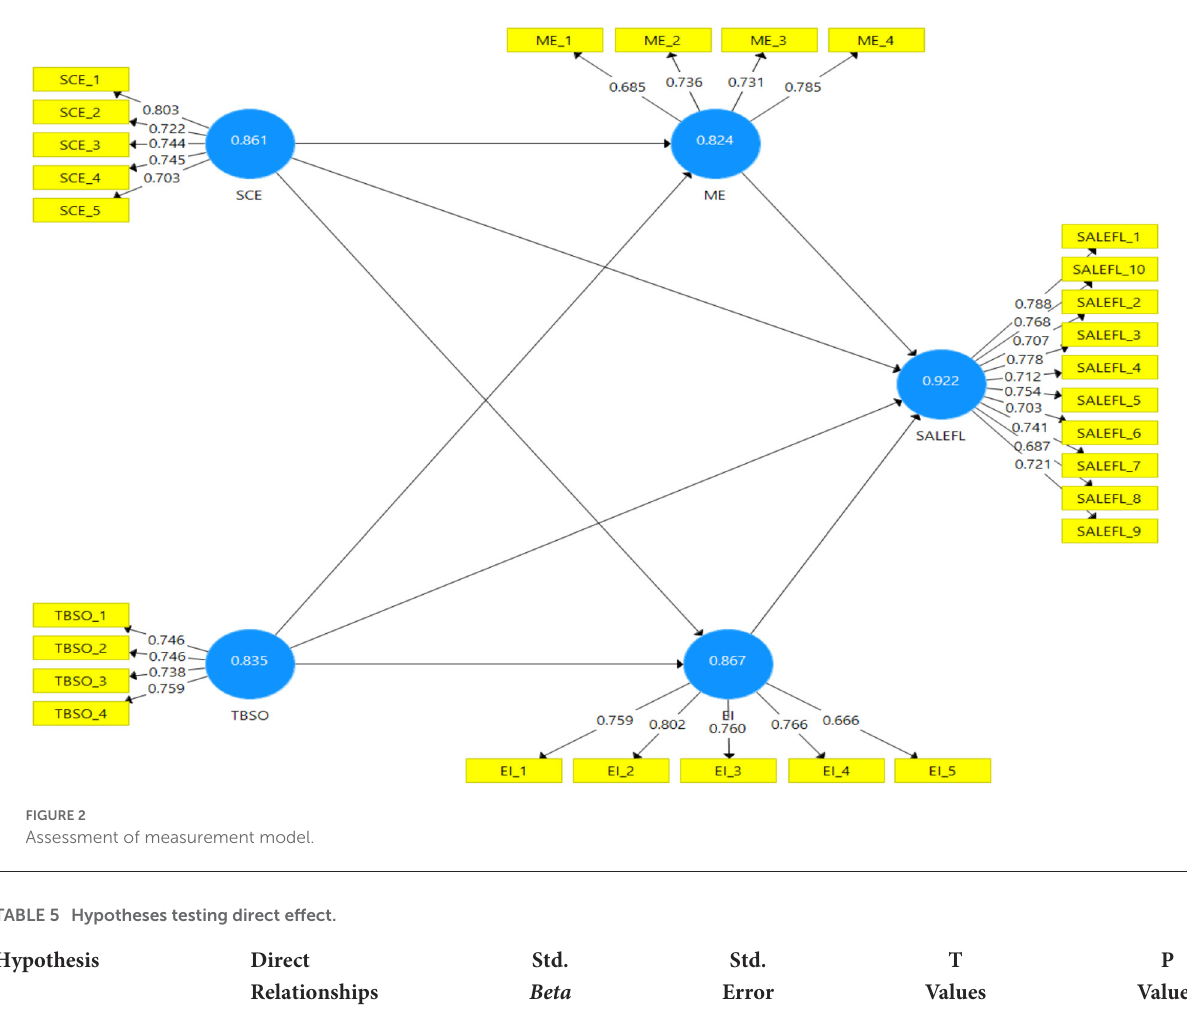
TABLE 5 Hypotheses testing direct